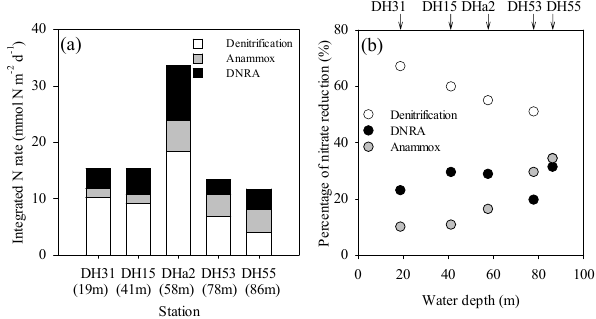
Fig. 6. Total nitrate reduction from denitrification, anammox and DNRA (a) and relative contribution of denitrification, anammox and DNRA as a function of water depth (b).